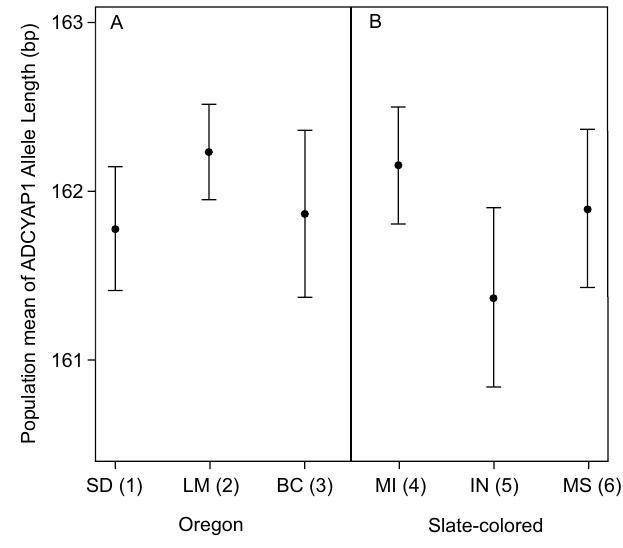
Figure 2. ADCYAP1 allele length within sub-species groups. ADCYAP1 allele length did not differ between populations within the sub-species for which we have multiple sampling locations. Shown are means and standard errors for Oregon juncos listed by breeding grounds (panel A) and slate-colored juncos listed by wintering grounds (panel B). Population migration scores are shown in parentheses with higher numbers indicating populations that migrate longer distances (see Table 1 for more